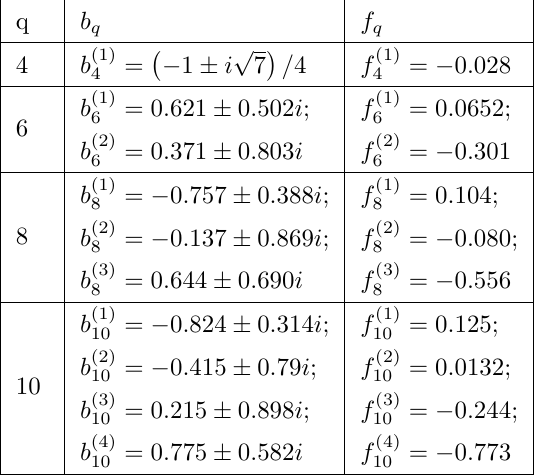
Table 1 . Complex roots of equation (5.60) and corresponding values of f